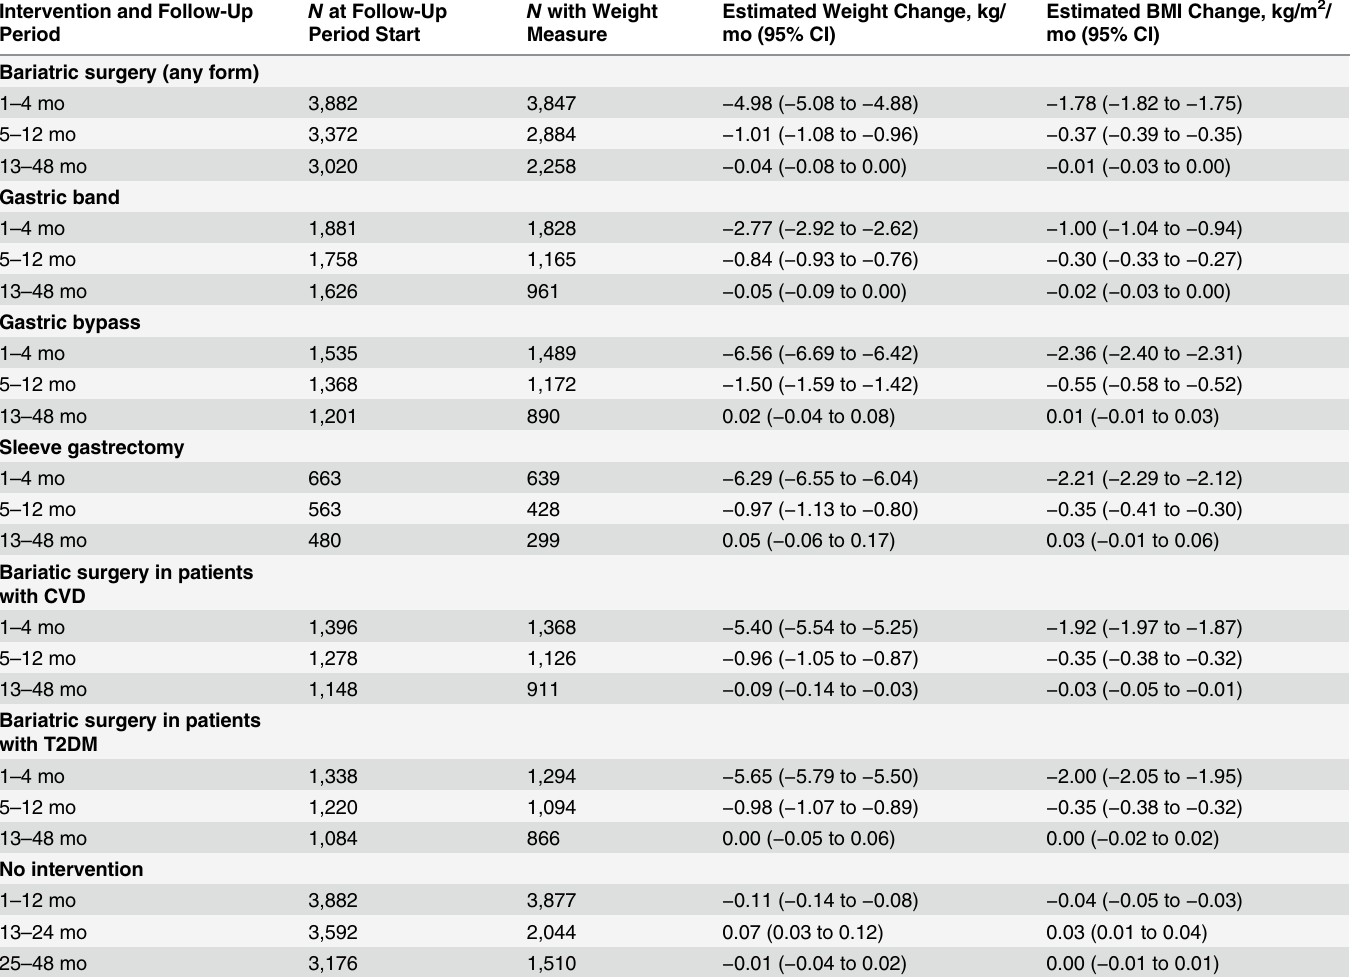
Table 2. Rate of change in weight and BMI over 3-y